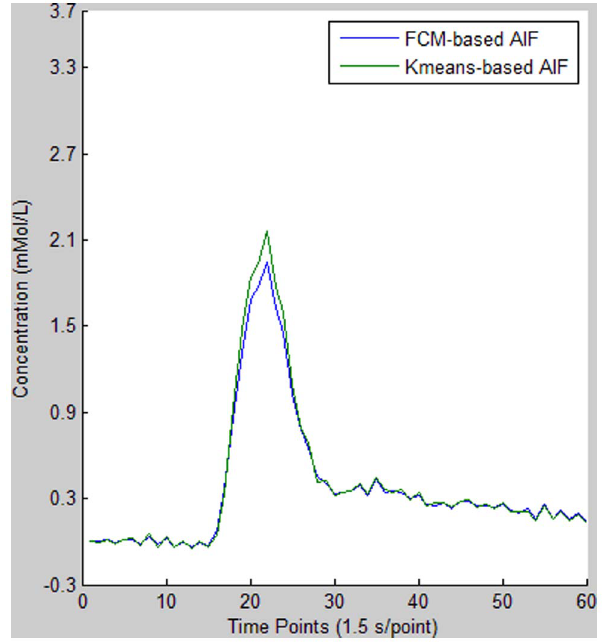
Figure 7. Comparison of AIFs derived from the FCM and K - means clustering methods. Relative to FCM, the K -means-based AIF shows similar TTP, higher PV, larger AUC, and narrower FWHM.